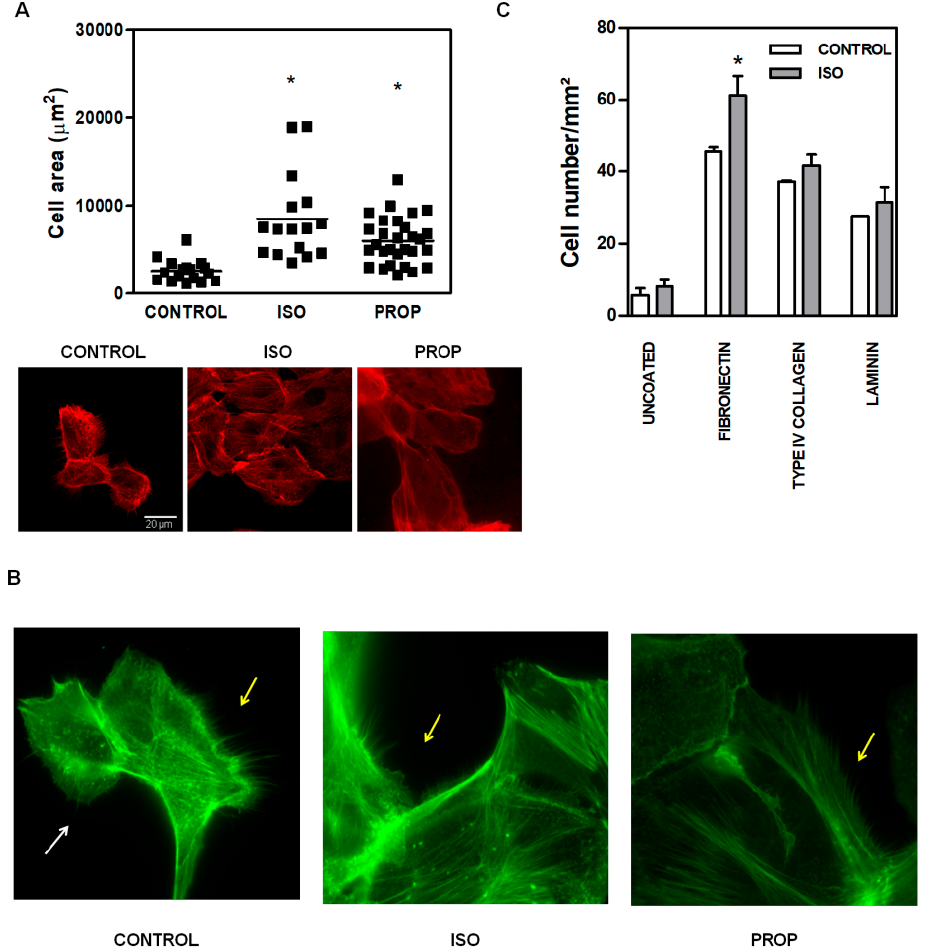
Figure 2. Increase of cell area and changes in actin cytoskeleton of MCF-10A cells induced by isoproterenol (ISO) and propranolol (PROP). ( A ). Fluorescence staining with phalloidin (red). Cells were treated or not treated (CONTROL) during 10 min with 1 µM ISO or 1 µM PROP and adherent cell area was quantified automatically with ImageJ. The scale is the same for every photograph. ( B ) Fluorescence staining with green phalloidin. White arrows show lamellipodia, while yellow arrows depict filopodia. ( C ) Agonist adhesion to specific extracellular matrix protein fibronectin, type IV collagen, laminin compared with uncoated control. Statistical significance was assessed using Kruskal–Wallis test ( A ) or ANOVA Bonferroni test ( C ). * p < 0.05. Data are representative of three independent experiments.